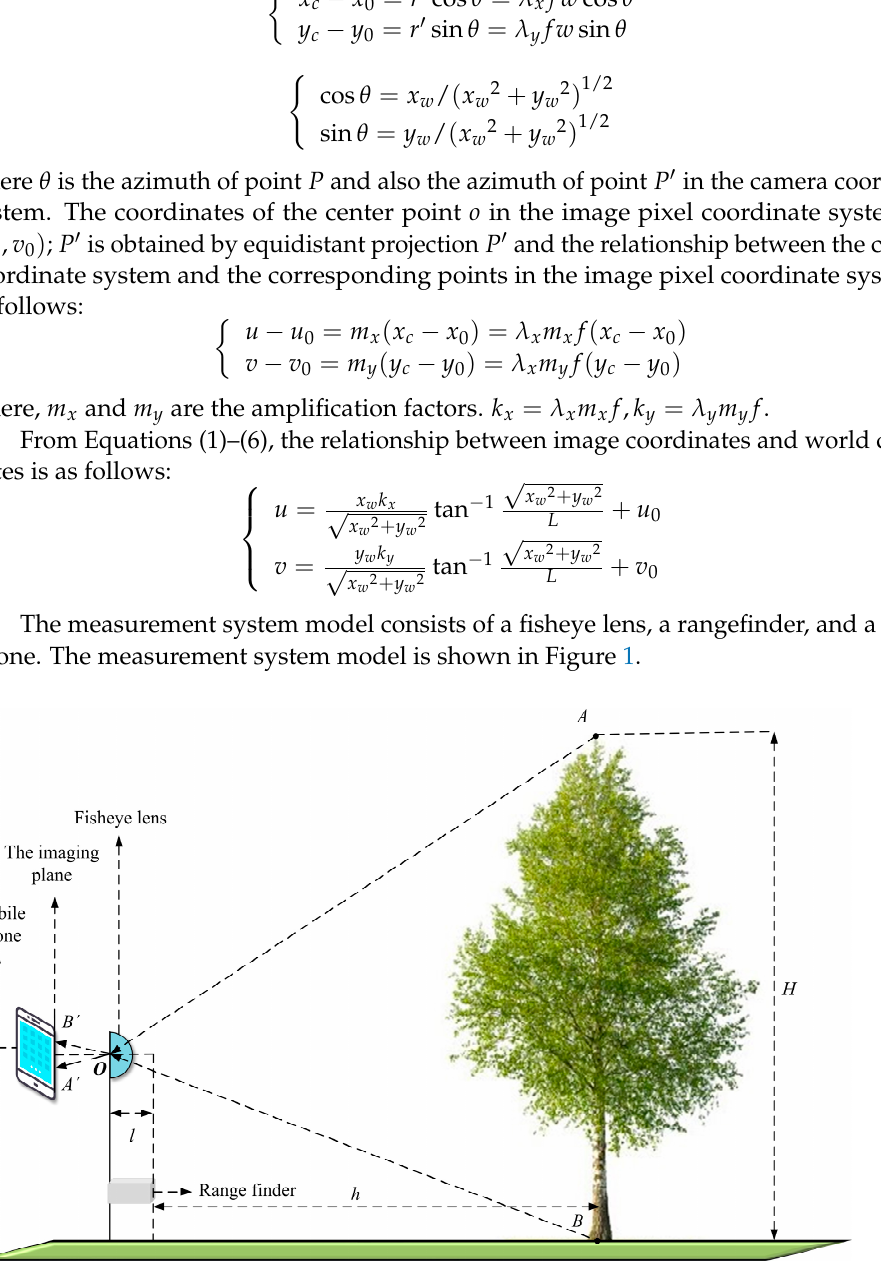
Figure 1. Measurement system model.